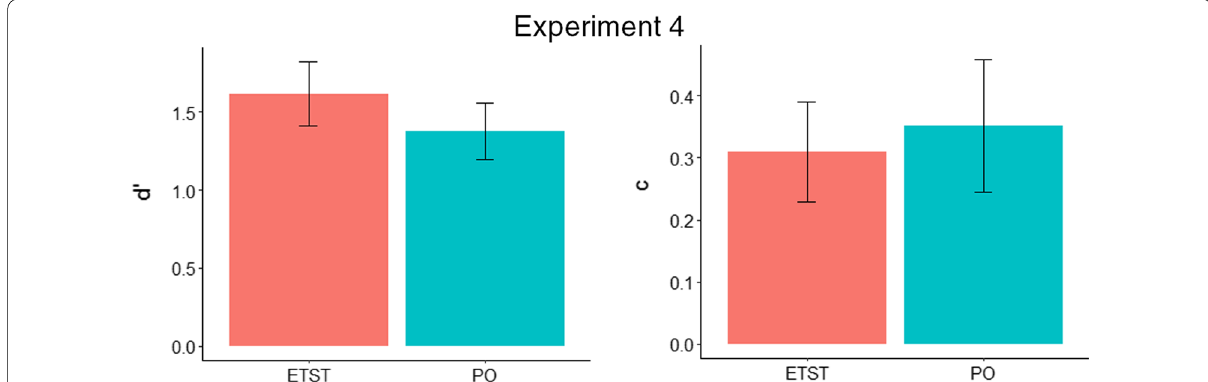
Fig. 11 d ′ and c for the enhanced targetless search training (ETST) and practice only (PO) groups in Experiment 4 (error bars show 95%